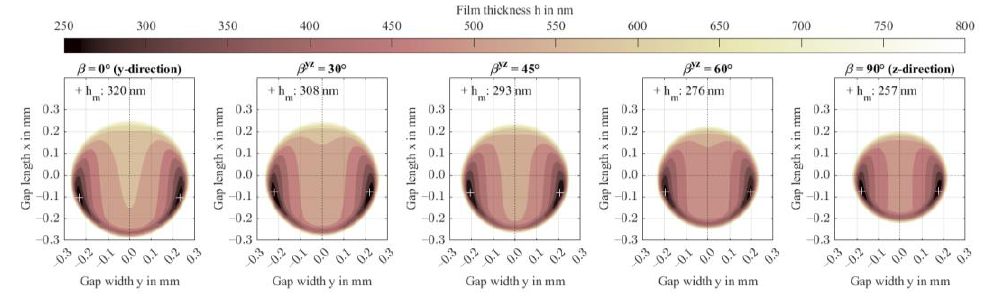
Figure 15. Film thickness contours including minima for variation of the rotation β yz of fiber orientation in the yz-plane.